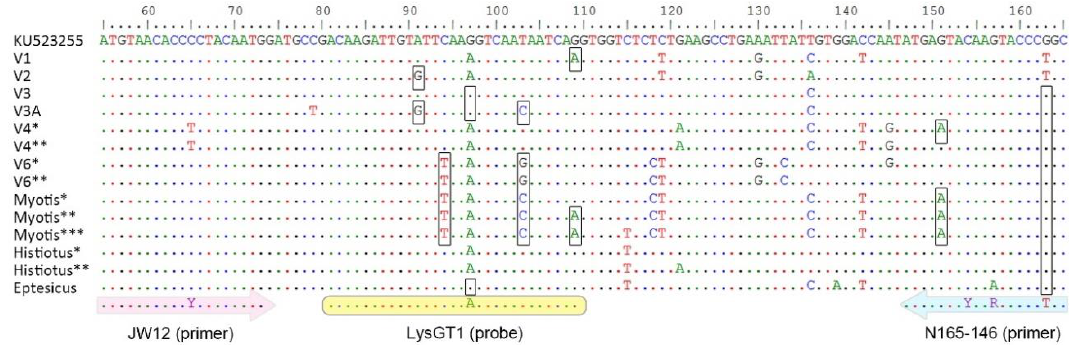
Figure 3. Alignment showing variability of Argentinian RABV genetic variants in the region comprising the amplicon used in the LysGT1 qRT-PCR assay. Primers JW12 and N165-146 and the probe LysGT1 were mapped in the resulting alignment. Dots depict conserved nucleotides. Mismatches of the primers and probe are indicated with black empty boxes. The sequence used as reference is a variant isolated from Desmodus rotundus (Genbank Accession Number: KU523255). The number of asterisks after variant denomination corresponds to different samples (Table 2). The remaining RABV variants depict no variation across samples in the region shown.